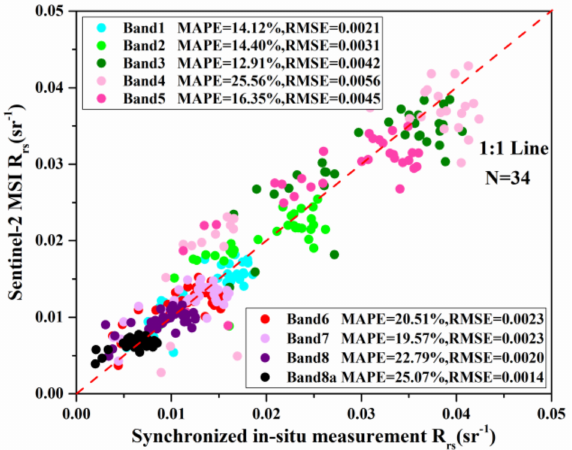
Figure 2. Performance of the Sen2Cor processor based on Sentinel-2